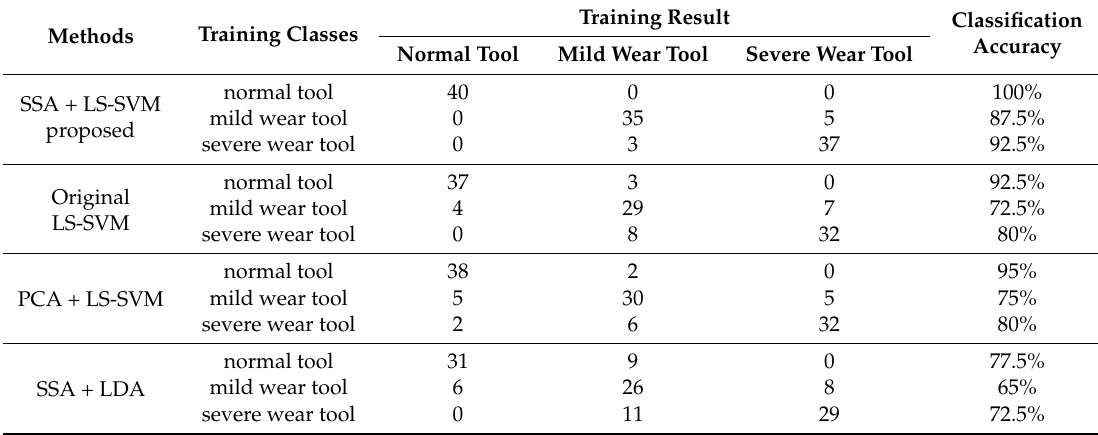
Table 2. Result of stationary subspace analysis (SSA) + least squares support vector machine (LS-SVM), original LS-SVM, Principal Component Analysis (PCA) + LS-SVM and SSA + linear discriminant analysis (LDA) with training set.